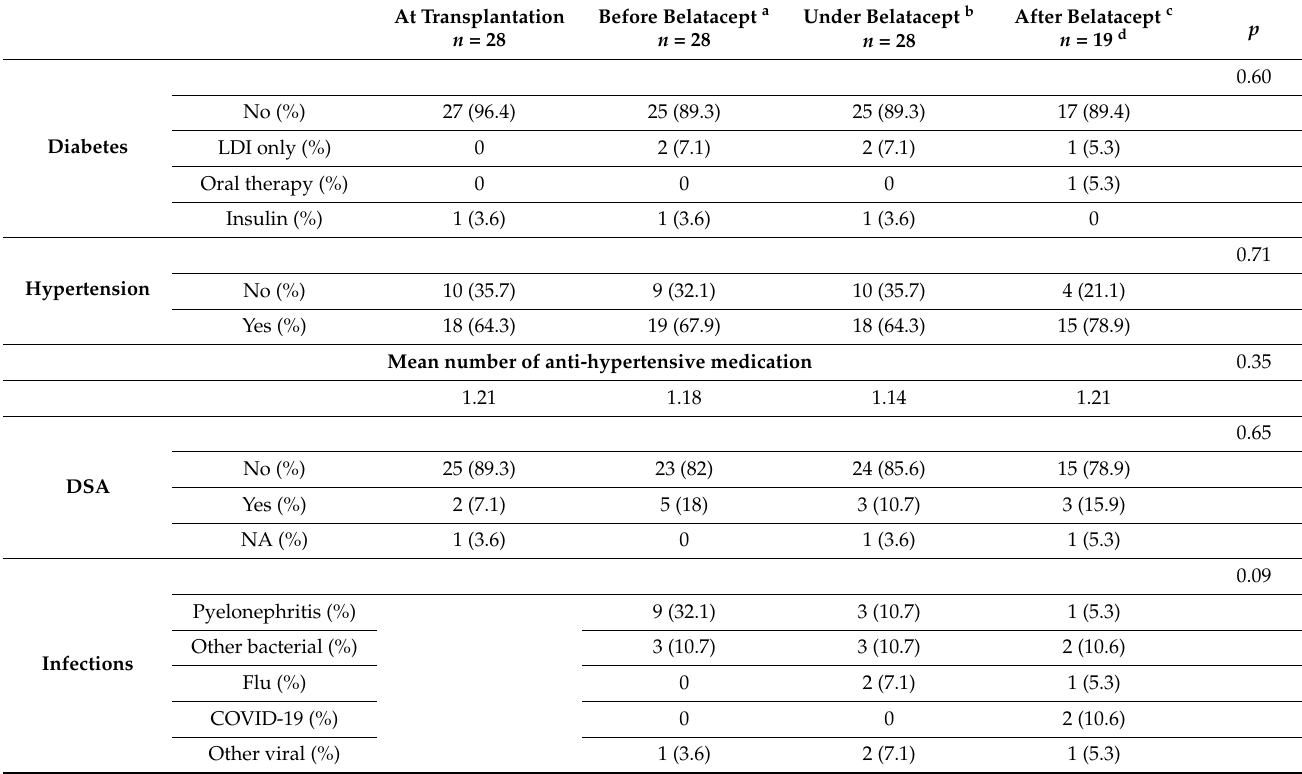
Table 3. Side effects according to the belatacept exposure